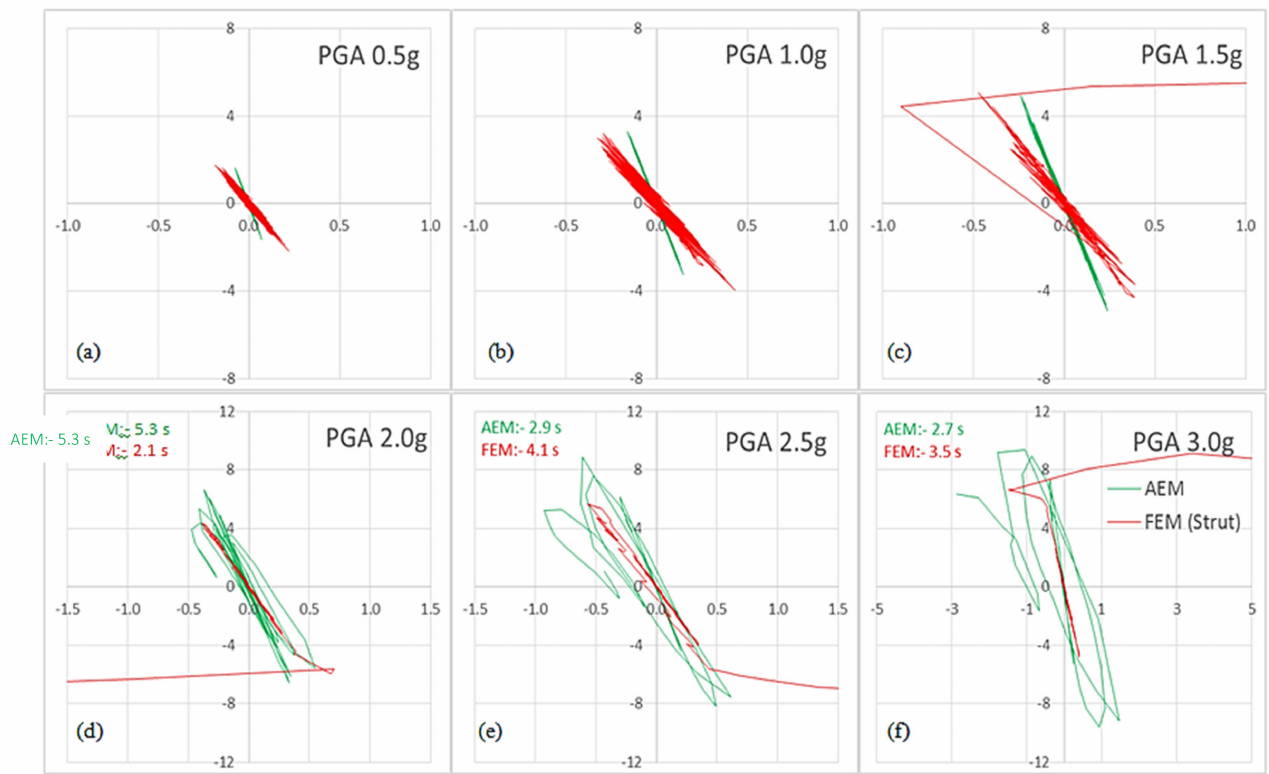
Figure 23. Comparison of base shear and top lateral displacements for FEMA strut and AEM models for IFM wall structure at PGA: ( a ) 0.5 g; ( b ) 1.0 g; ( c ) 1.5 g; ( d ) 2.0 g; ( e ) 2.5 g; ( f ) 3.0